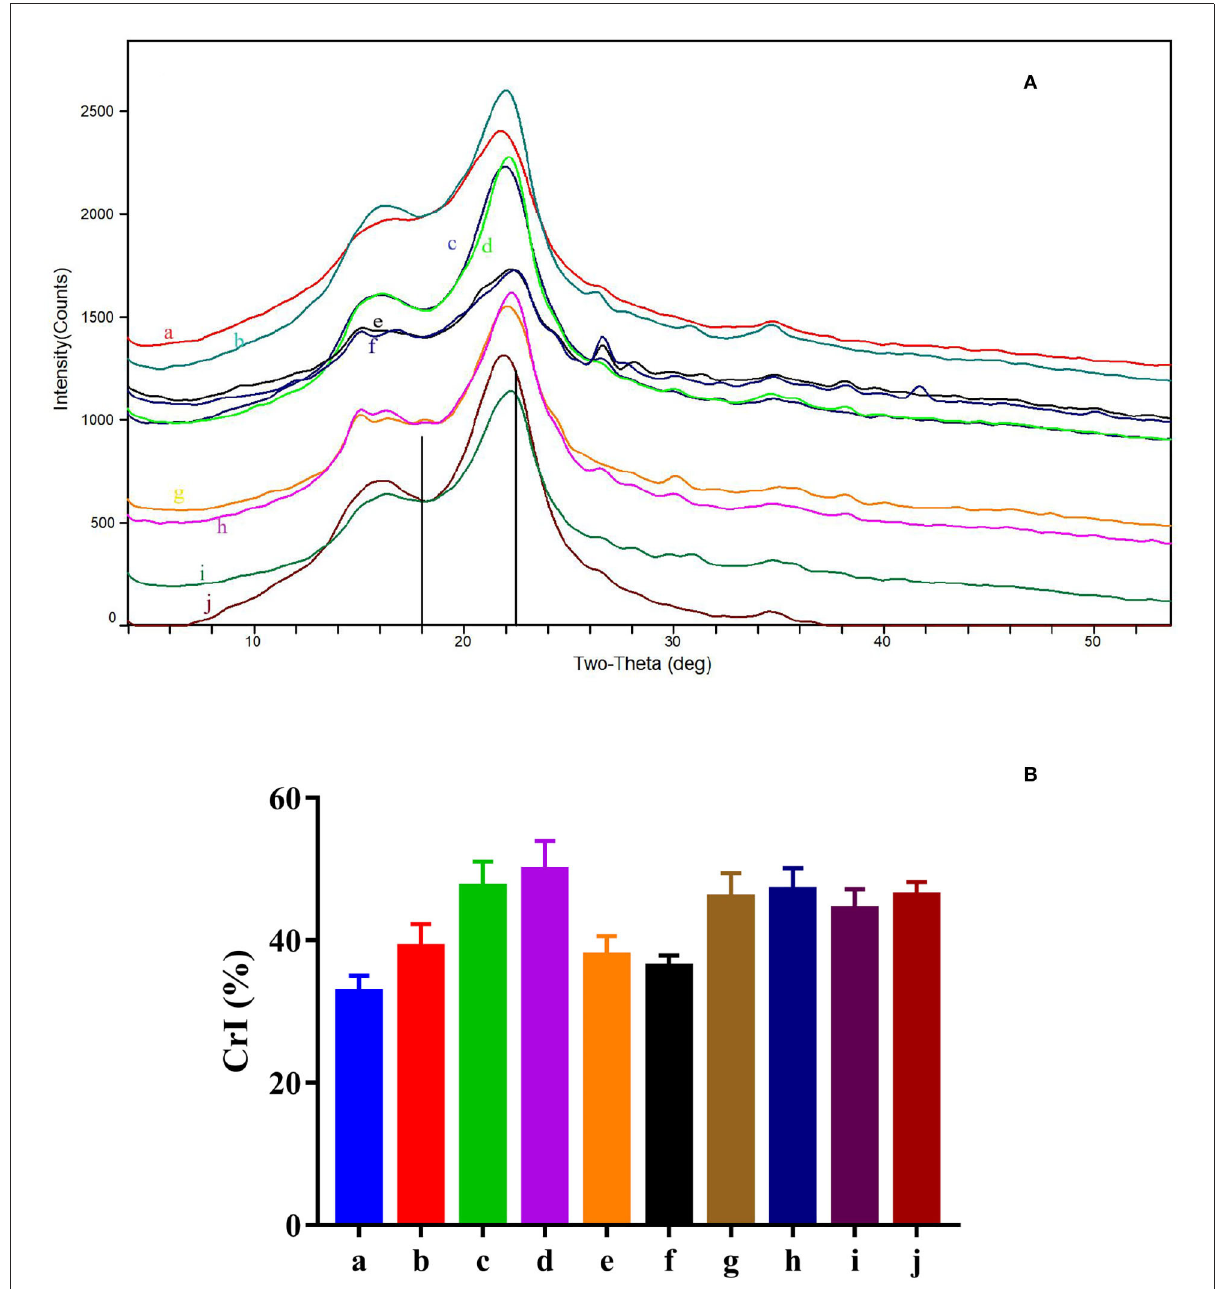
FIGURE3 XRD images (A) and cellulose crystalline index (CrI) (B) of feedstuffs before and after steam explosion processing (a: raw corn cob; b: steam-exploded corn cob; c: raw rice straw; d: steam-exploded rice straw; e: raw peanut shell; f: steamed-exploded peanut shell; g: raw millet stalk; h: steamed-exploded millet stalk; i: raw sugarcane tip; j: steam-exploded sugarcane